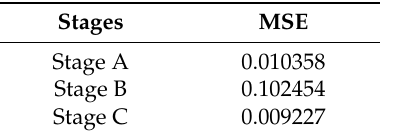
Table 1. MSE corresponding to each